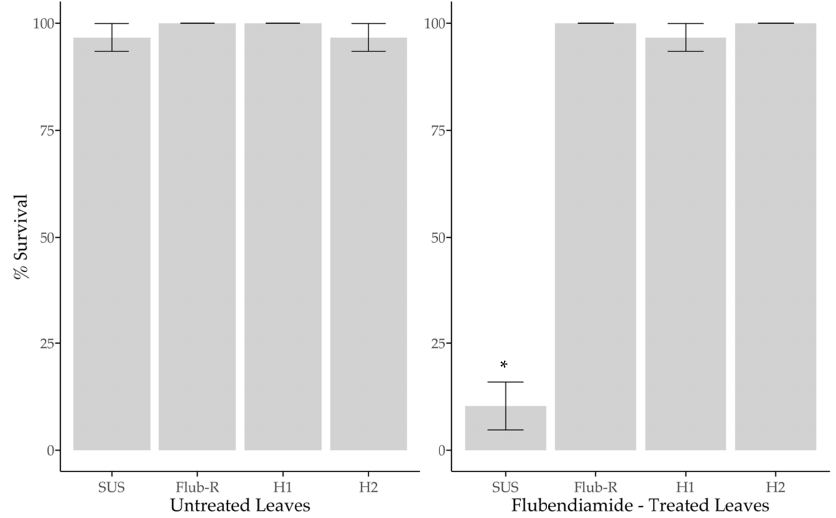
Figure 2 . Proportion of larval survival by susceptible (SUS), resistant (Flub-R) and heterozygous H1 ( ♀ SUS X ♂ Flub-R) and H2 ( ♀ Flub-R X ♂ SUS) H. armigera in soybean leaves untreated and treated with flubendiamide (0.33 µ g a.i. cm − 2 ). * Significant difference between strains according to the Tukey’s test ( p < 0.05).